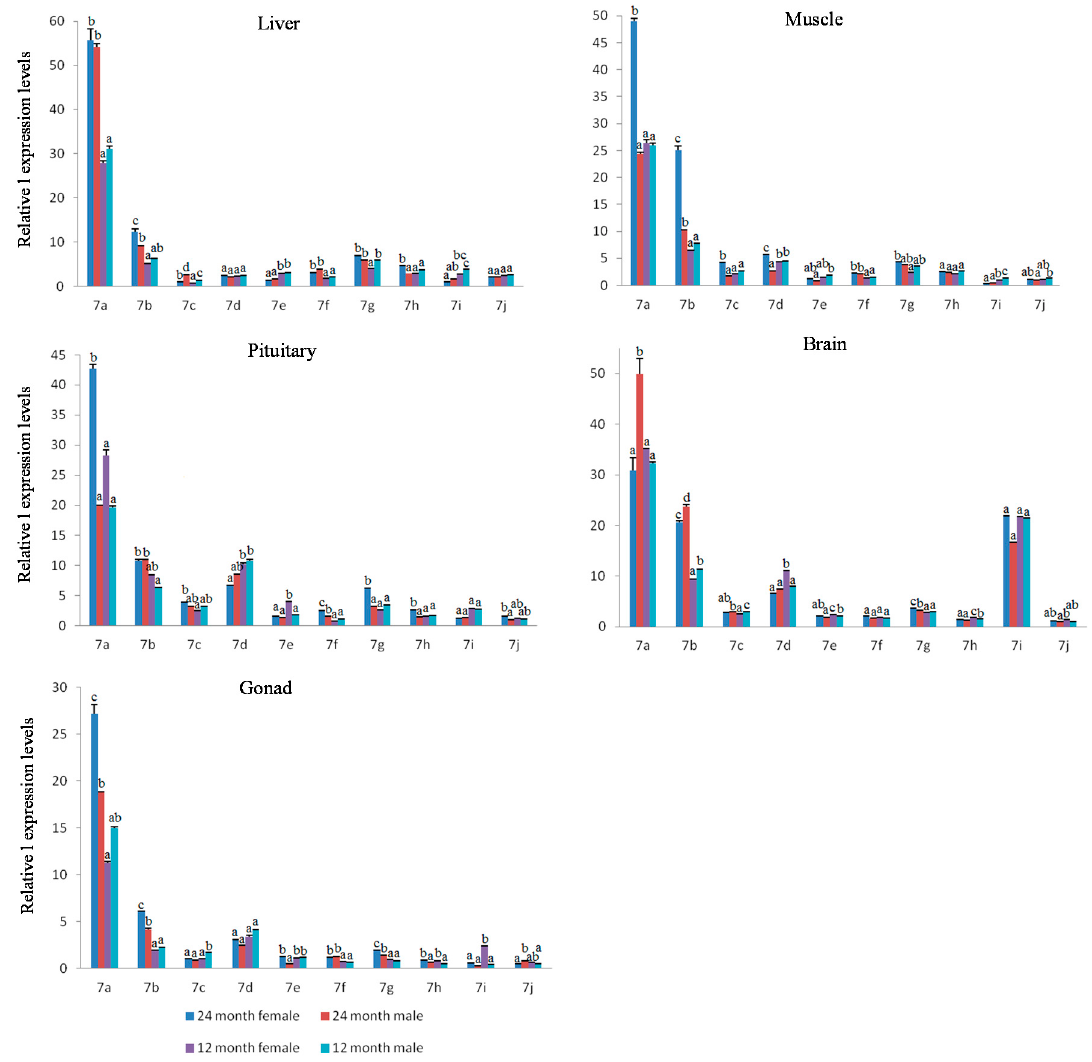
Figure 6. The relative expression levels of let-7 miRNAs ( let-7a/b/c/d/e/f/g/h/i/j ) in liver, muscle, pituitary, brain and gonad tissues at 12- and 24-months-old M. amblycephala (females and males). Values with the same letter mean no significant difference ( p > 0.05) for each miRNA in females and males at 12- and 24-months-old M. amblycephala .